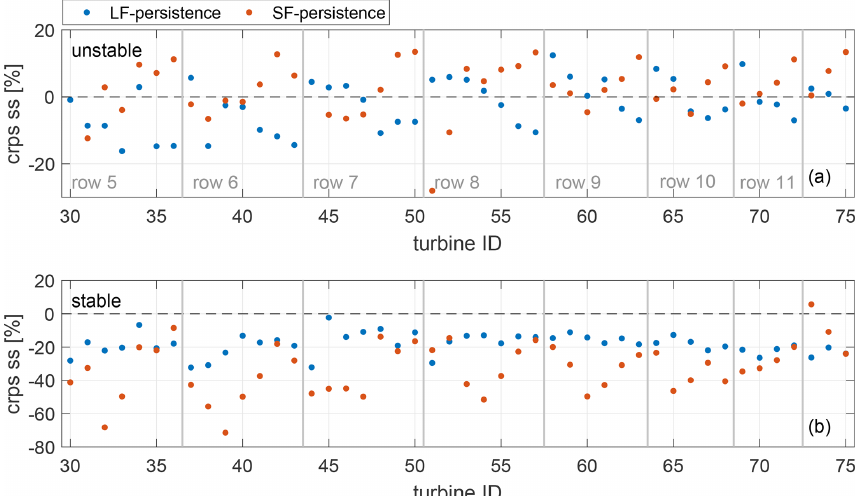
Figure 4. The crps ss of LF and SF with persistence as reference for individual turbines of GT I and distinguishing between (a) unstable and (b) stable atmospheric conditions. Grey vertical lines mark horizontal wind turbine